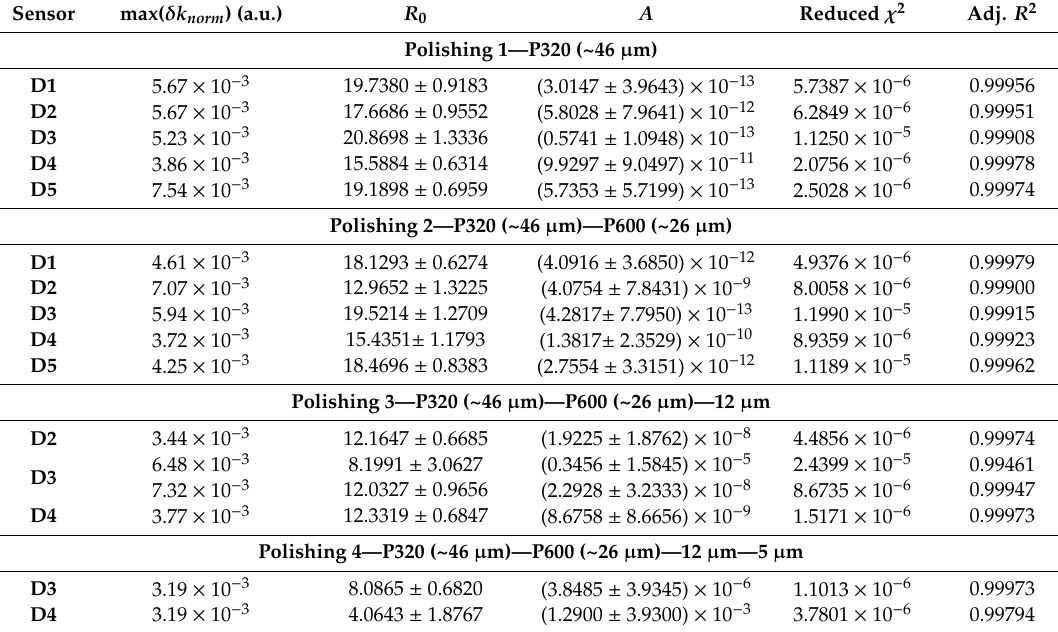
Table 4. Obtained results from the RI characterizations and exponential